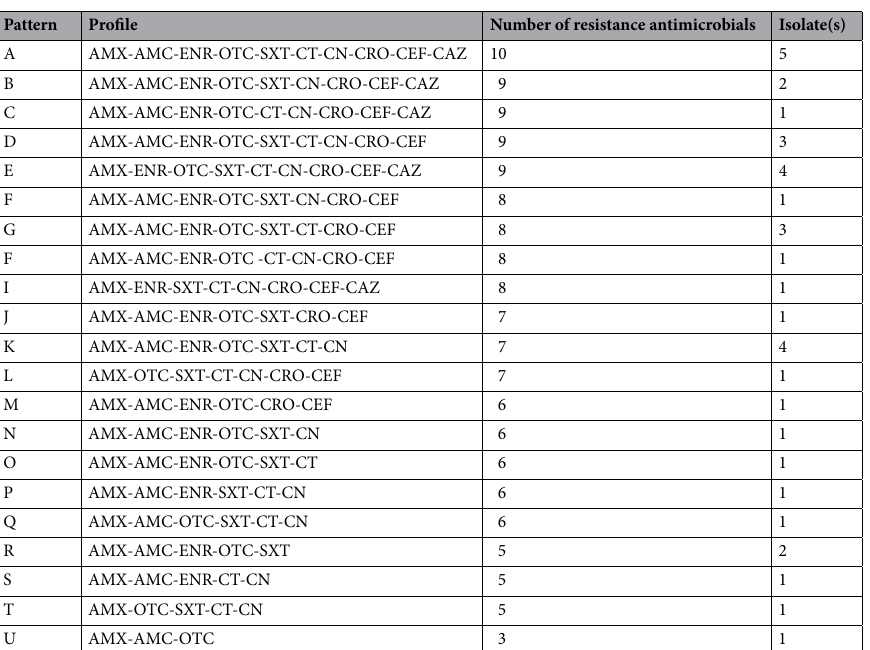
Table 2. Antibiograms based on the MIC results of 37 E. coli strains distributing into 21 pattern types (A-U). AMX amoxicillin, AMC amoxicillin: clavulanic acid, CEF ceftiofur, CAZ ceftazidime, CRO ceftriaxone, CT colistin, ENR enrofloxacin, CN gentamicin, OTC oxytetracycline, SXT